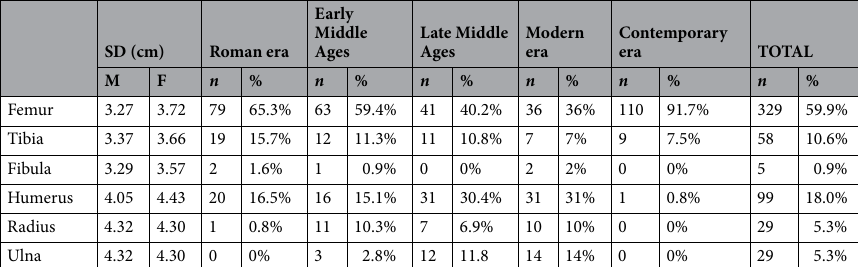
Table 4. Frequency of bone use for stature estimation in the